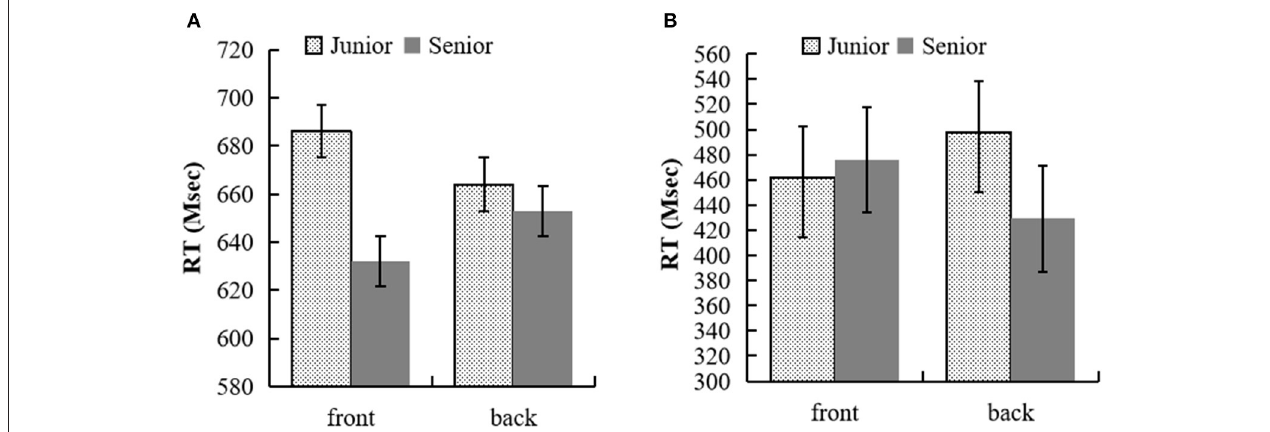
FIGURE 3 | (A) RTs (in proportions) for the semantic judgment task of kin terms in experiment 3a. (B) RTs (in proportions) for initiating the sensibility judgment response in experiment